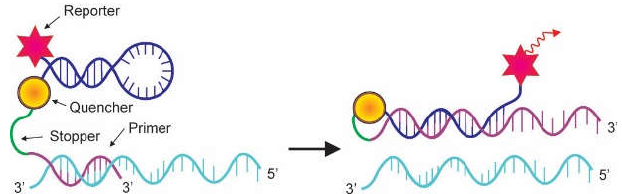
Figure 6. Mechanism of action of Scorpion probe. The scorpion probe adopts a stem-and-loop conformation held by complementary stem sequences on the 5′ and 3′ sides of the probe. A fluorophore is attached to the 5′ end, and a quencher is linked to the 3′ end of the probe. A specific probe sequence is held within the hairpin loop, which is linked to the 5′ terminus of a PCR primer sequence by a PCR stopper. This chemical variation hinders PCR from amplifying the stem-loop sequence of the scorpion primer. In the course of PCR, scorpion primer is elongated to generate an amplicon. In the annealing phase, the specific probe sequence in the scorpion tail curls back to hybridize with the complementary target sequence in the amplicon, hence opening up the hairpin loop. This prevents the fluorescence from being quenched, and a signal is detected (Adapted from Arya et al. [5]).